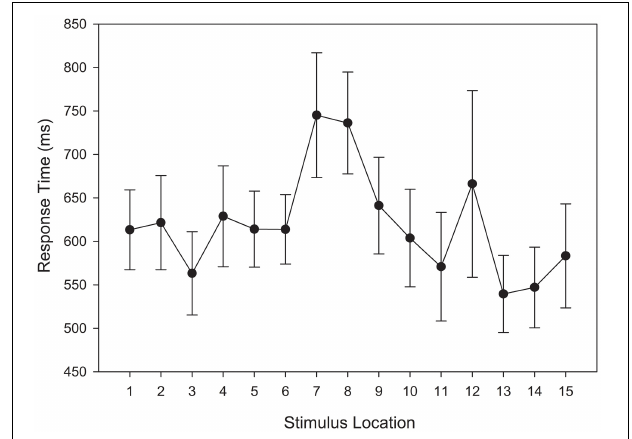
FIGURE 12 | Test categorization response accuracy in the unequal frequency, unequal distribution condition. Stimulus values correspond to stimuli selected from the training range (i.e., stimuli 3–13). Error bars represent 1 standard error of the mean ( N = 60).